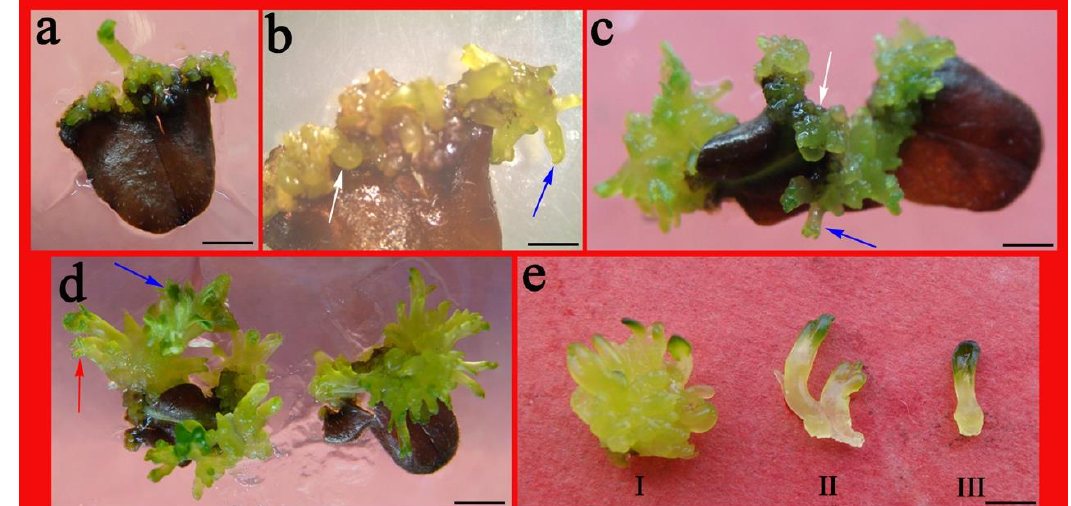
Figure 3. In vitro shoot regeneration and ELSs induction from A. lupulina leaf explants on MS medium plus 3.0 mg L −1 BA and 0.1 mg L −1 NAA. ( a ) Light-green callus formation at the edge of the browned blade following 3 weeks of culture. ( b ) Appearance of adventitious shoots (blue arrow) and some globular- shaped (white arrow) somatic embryos on the leaf explant surface following a 4-week culture. ( c ) Adventitious shoot (blue arrow) development and globular-shaped (white arrow) ELSs. ( d ) cotyledon-shaped (red arrow) formed and then developed into real shoots (blue arrow) after culture for 5 weeks. ( e ) Torpedo-shaped (I) and cotyledonary embryo (II,III) individual. Bar = 5 mm ( a ), 2 mm ( b ), 1 mm ( c – e ).